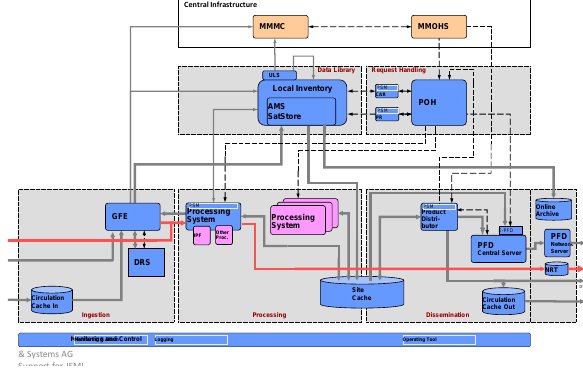
Figure 1: MMFI Architecture Overview